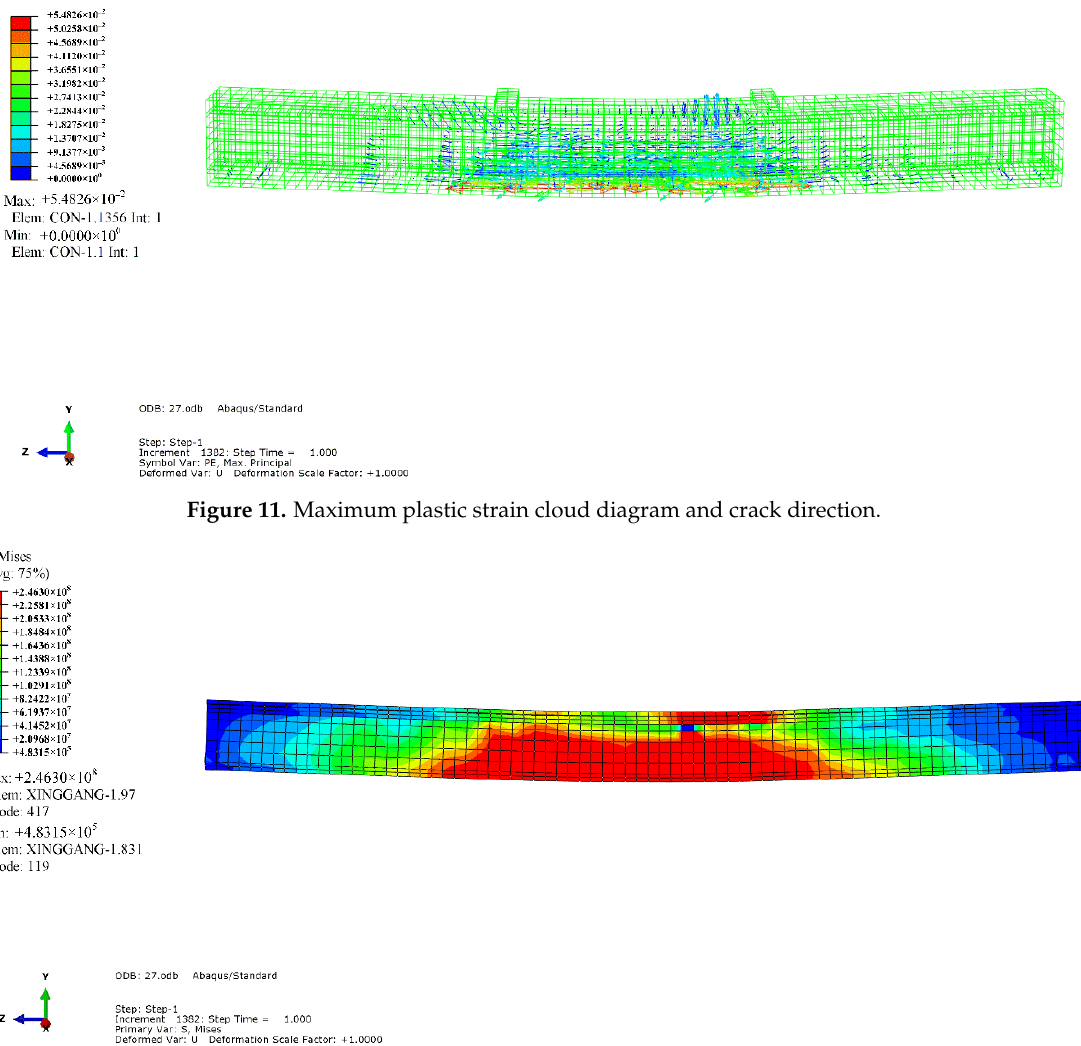
Figure 13. RPC tensile damage factor cloud diagram.